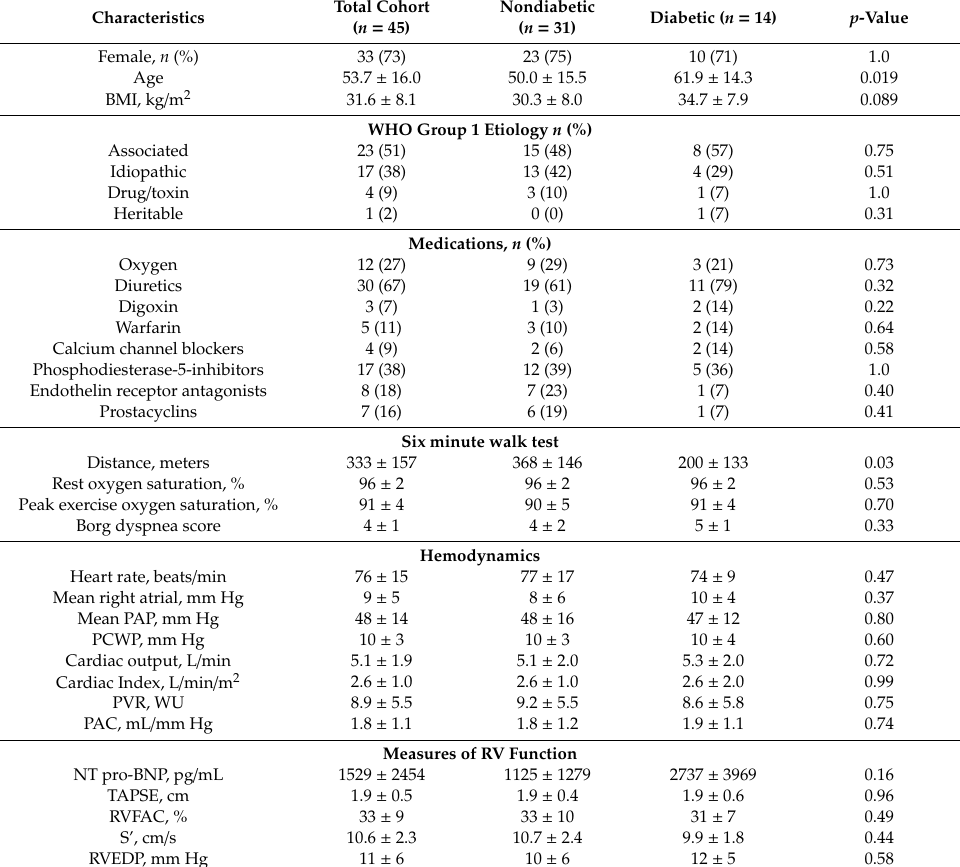
Table 2. Clinical characterization of PAH